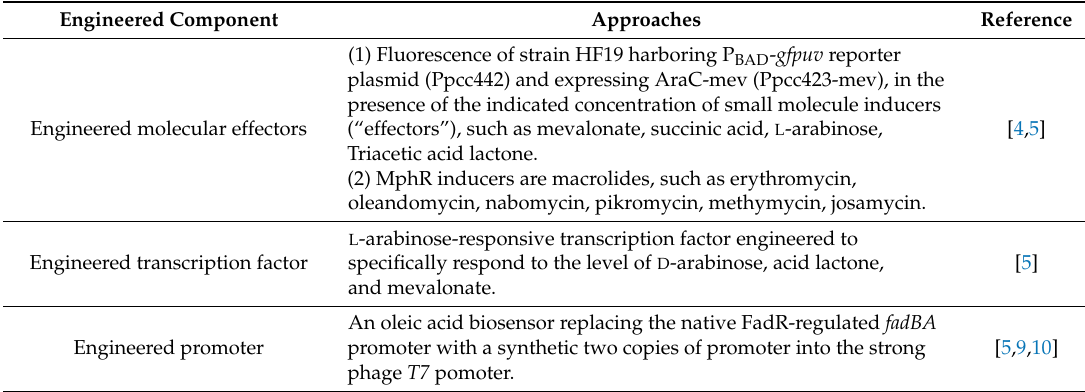
Table 1. Promoters, transcription factors, and molecular effectors engineered for the construction of biosensors.